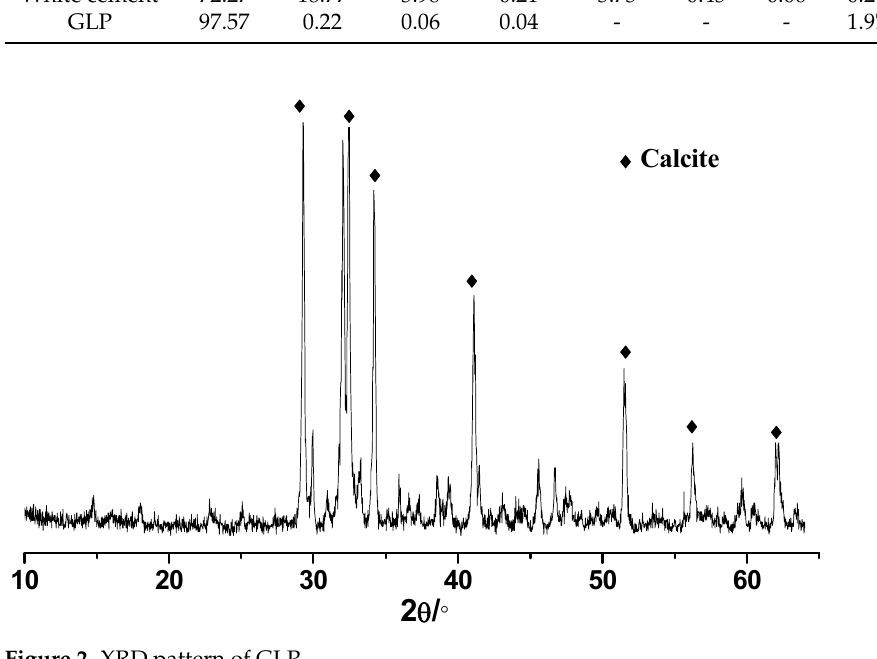
Figure 2. XRD pattern of GLP.